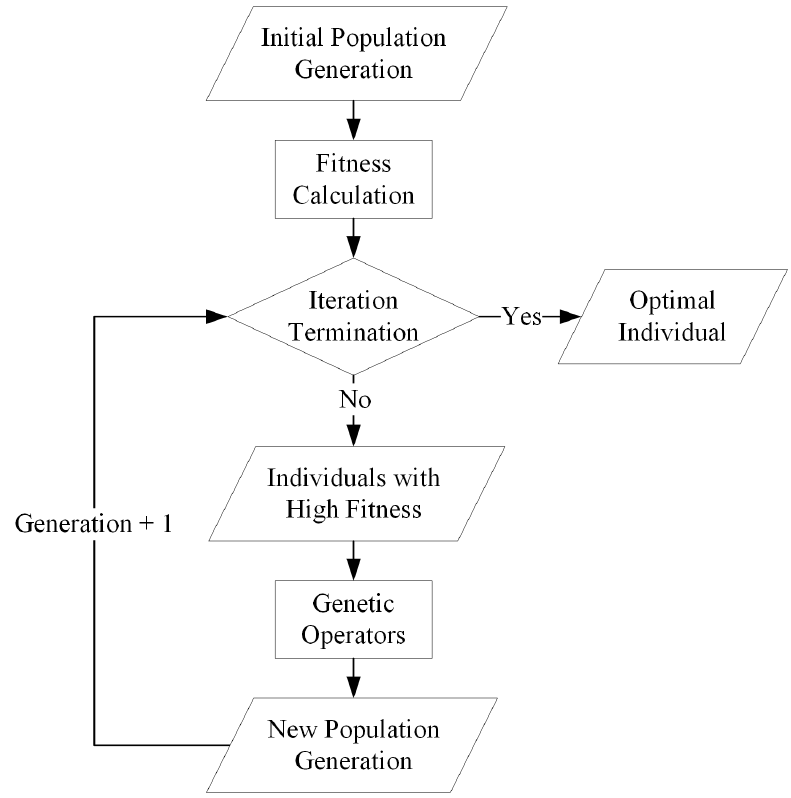
Figure 8. The flowchart of GP